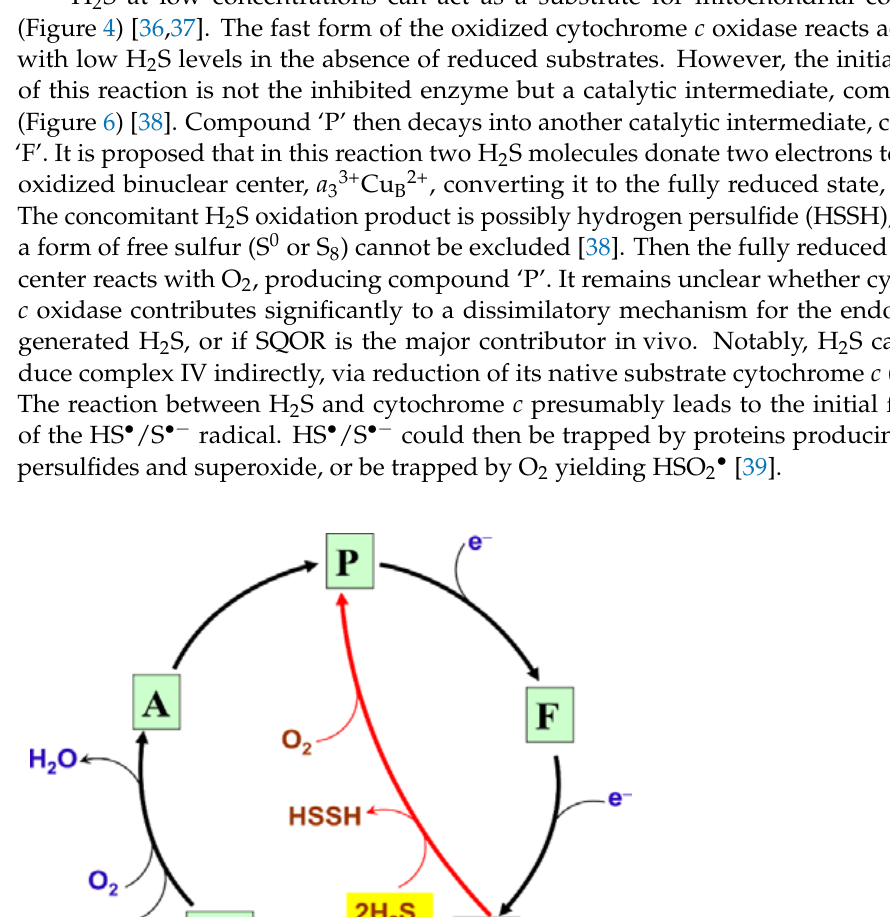
8 of 19 Figure 5. Proposed mechanism of inhibition of mitochondrial cytochrome c oxidase and Escherichia coli cytochrome bo 3 by H 2 S. Shown is the catalytic binuclear center in different redox and ligation states. The center consists of the copper ion Cu B and the high-spin heme ( Fe hs ). The latter is heme a 3